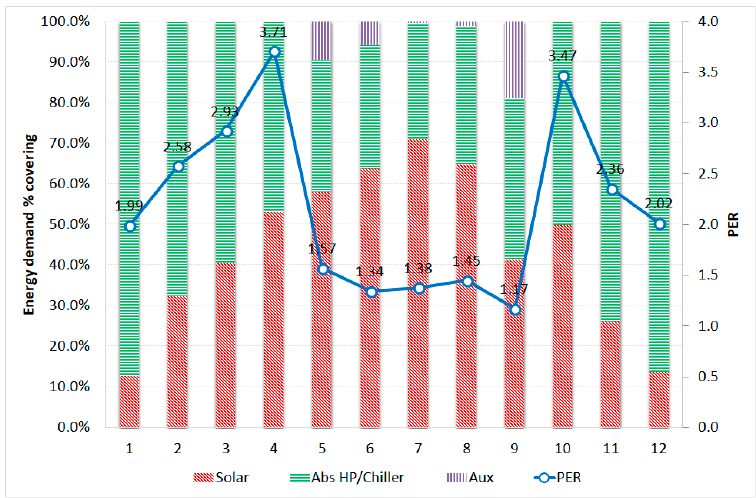
Figure 15. Energy demand percentage covering of different energy sources and the primary energy ratio (PER) (alternative A3).